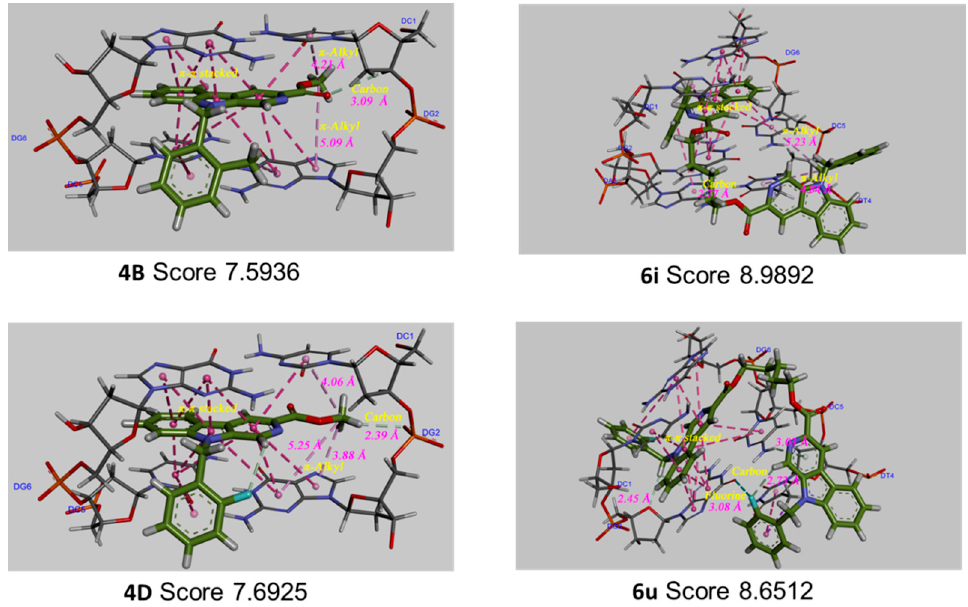
Figure 7. Three-dimensional conformations of the complexes of β -carbolines ( 4B , 6i , 4D , and 6u ) docked with DNA.